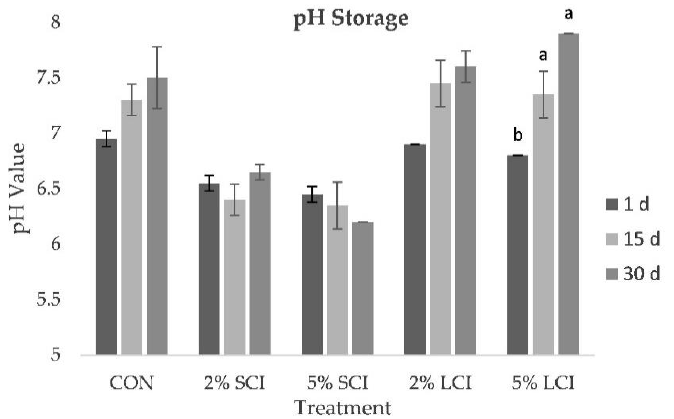
Figure 2. pH values of the five almond beverage treatments taken at 1, 15, and 30 days of storage. CON, control; SCI, short-chain inulin; LCI, long-chain inulin. Means with different letters in the same group indicate significant differences between measurement times ( p < 0.05).